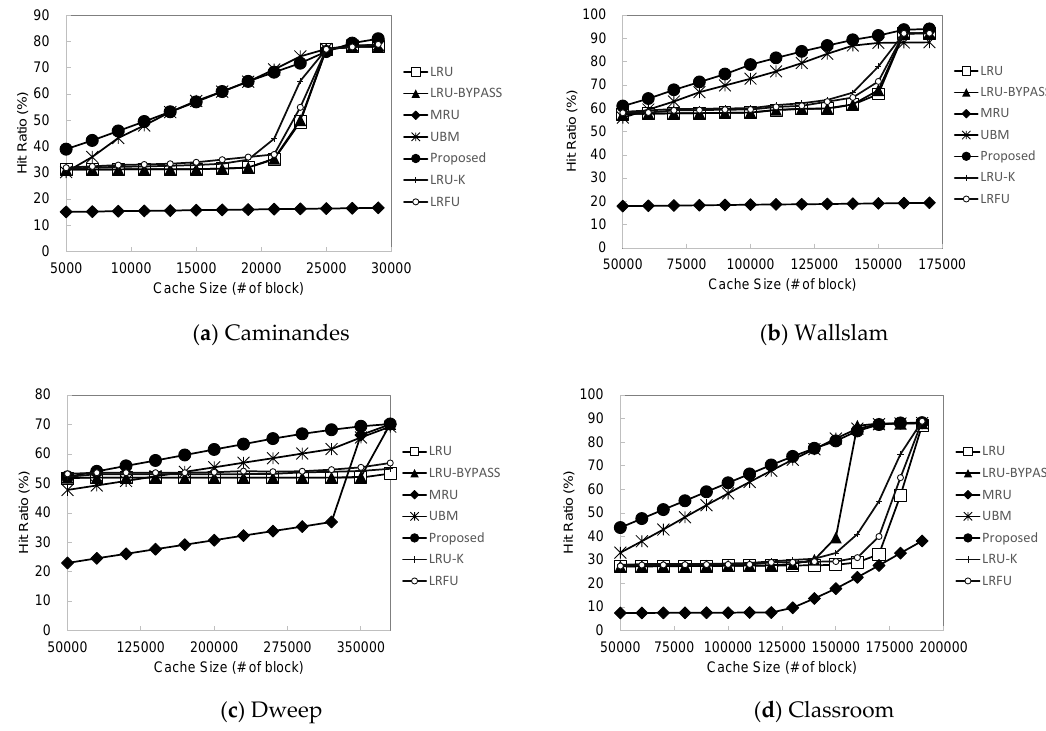
ff er cache management